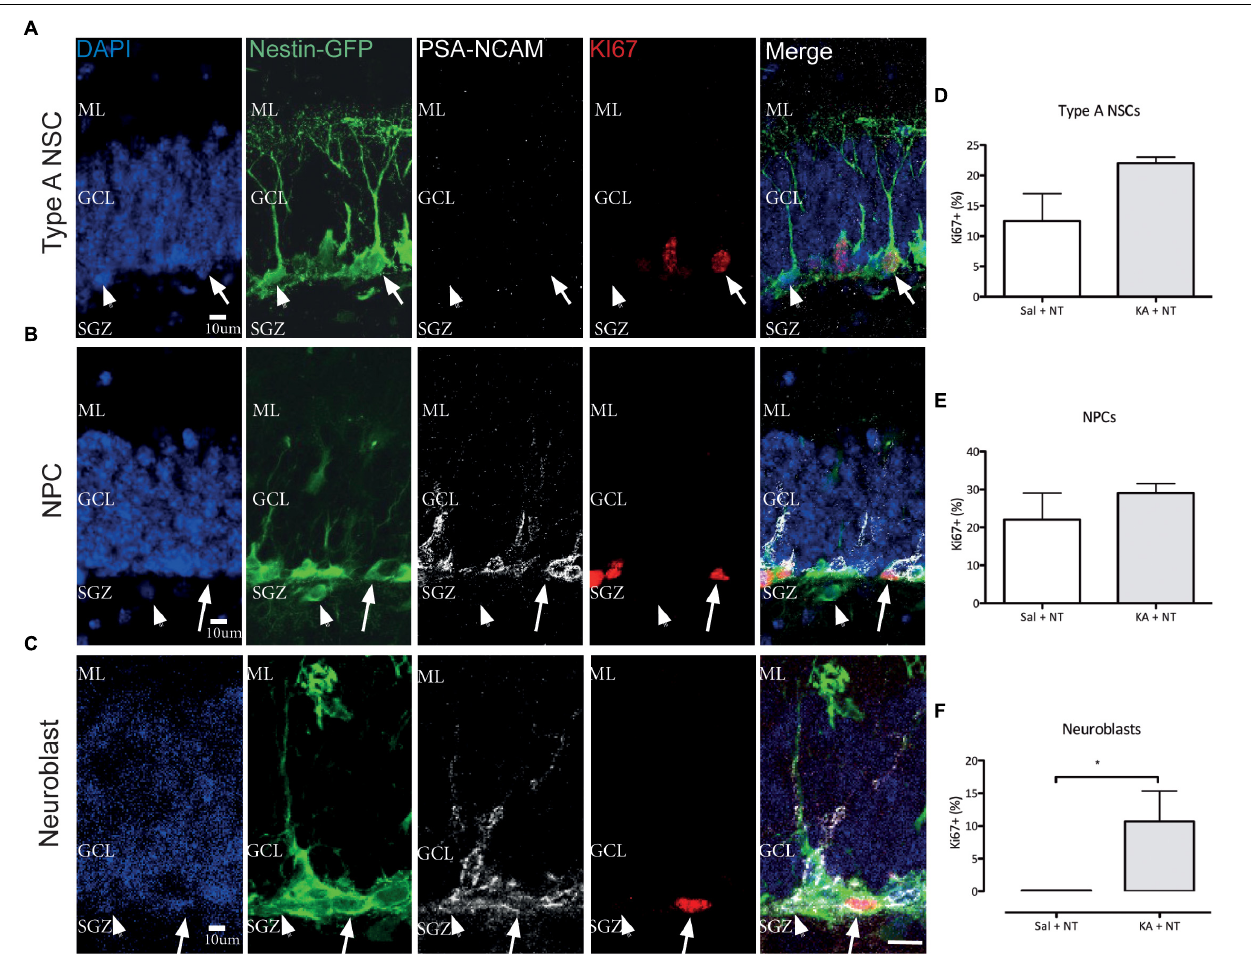
FIGURE 3 | Effects of non-convulsive seizures on NSPC proliferation. Example confocal images of (A) Type A NSCs, (B) NPCs, and (C) Neuroblasts analyzed. (D–F) Quantification of Ki67+ proliferative cells among (D) Type A NSCs, (E) NPCs, and (F) Neuroblasts. The relative proliferative proportion of both Type A NSCs and NPCs did not change upon the induction of ncSZ, while a significant induction of proliferation was observed in neuroblasts. ∗ P < 0.05.